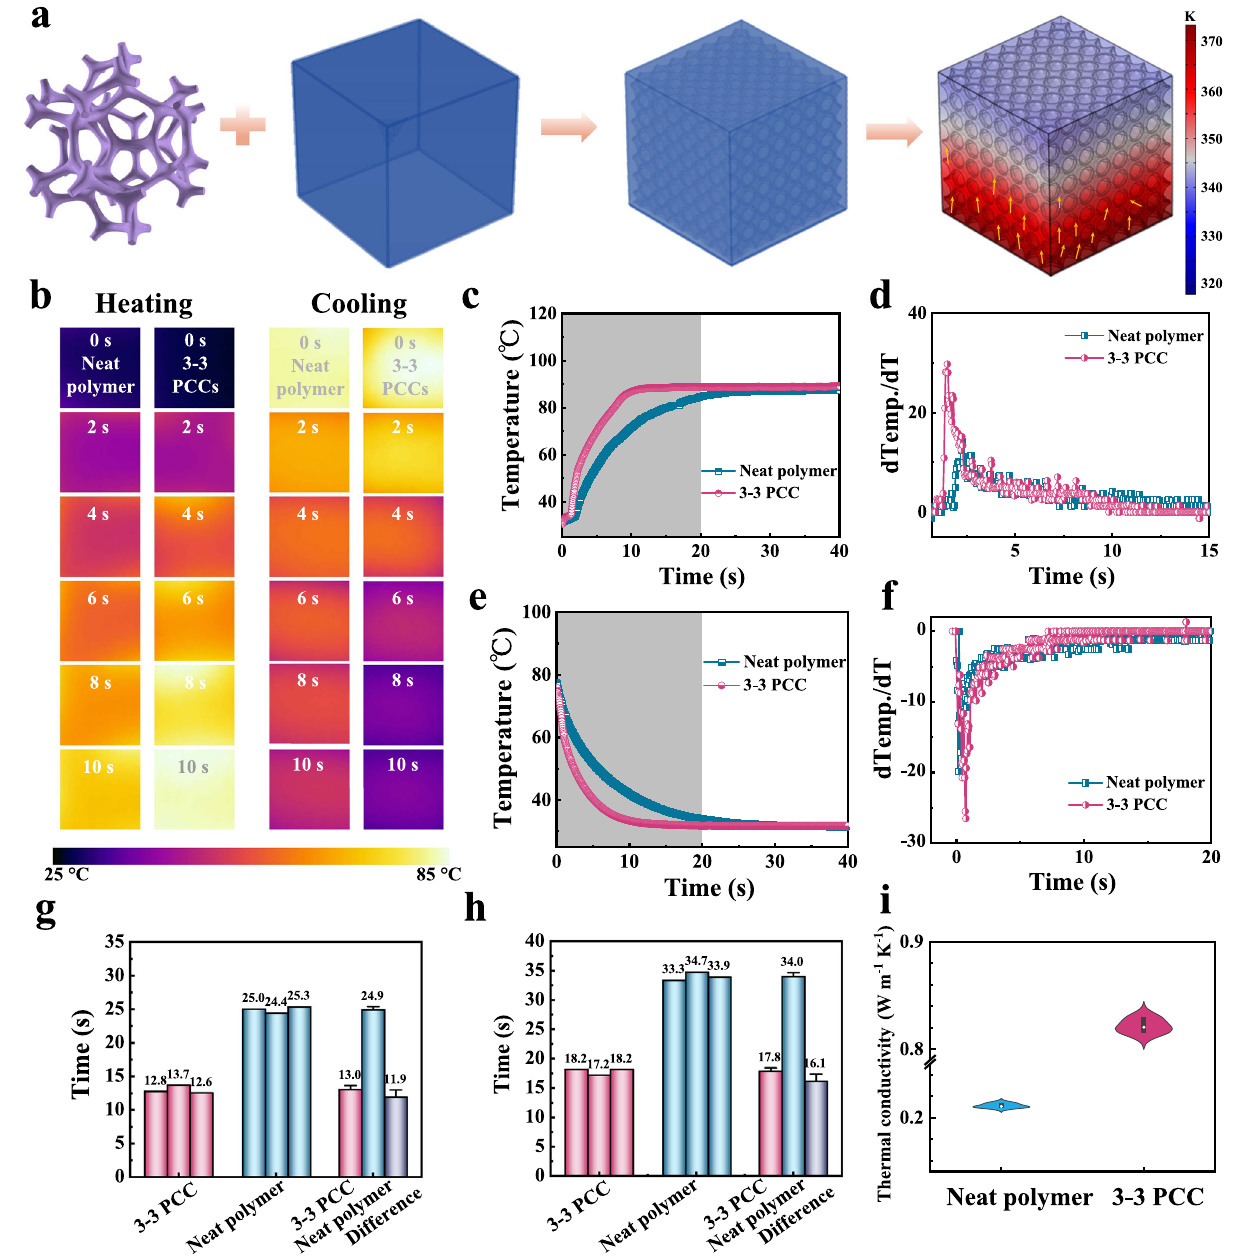
Fig.2|Excellentthermalconductivityof3-3PCCmaterials.a Schematicdiagram of the optimized 3-D heat conduction structure by fi nite element simulation. b Infrared thermal images at selected time. c , e The curve of temperature versus